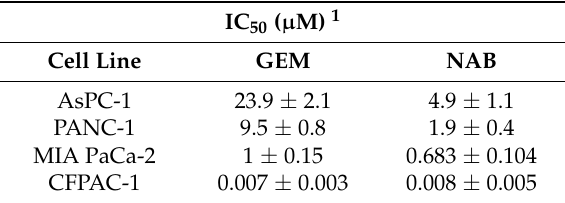
Table 1. IC 50 values of pancreatic cancer cells treated with gemcitabine and